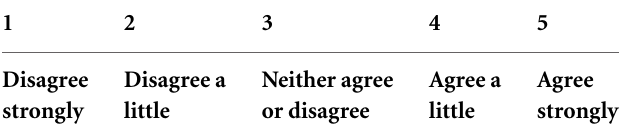
Scoring Information : NR-6 score is calculated by averaging all 6 items.